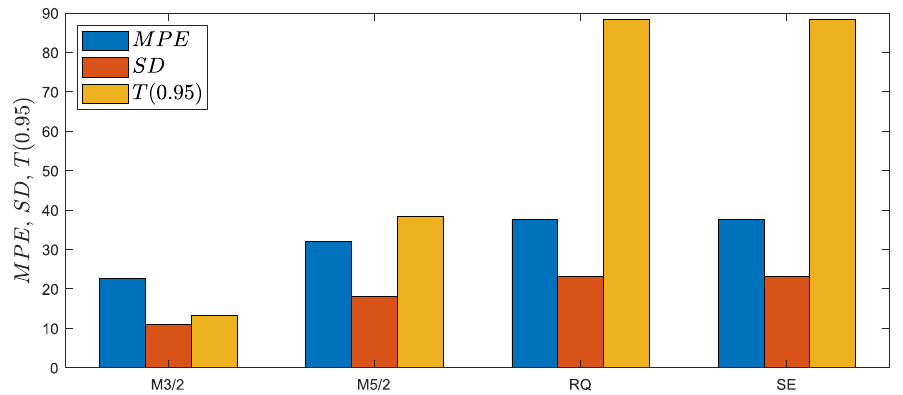
Figure 7. Comparison of error indexes obtained by application of different kernels to the fatigue GP-based model trained on the first training dataset.